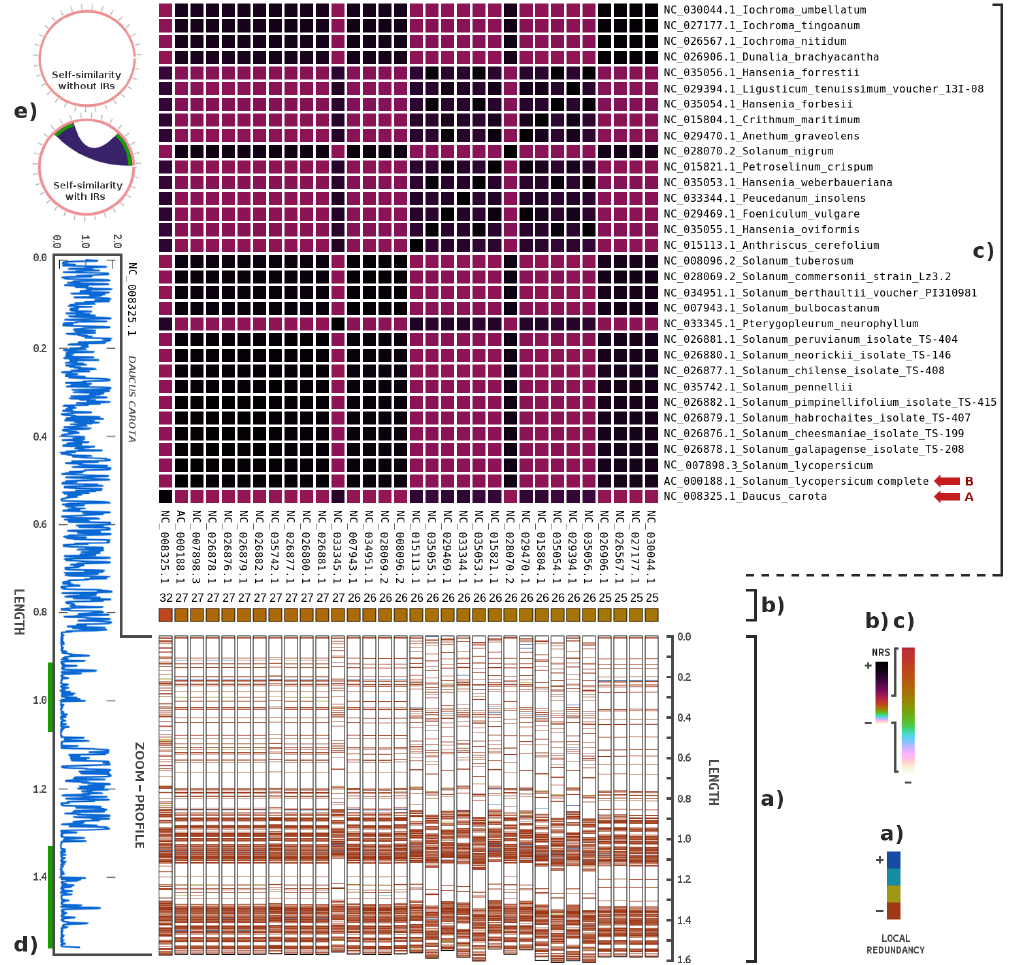
Figure 4. Metagenomic composition analysis of the PUM sample, particularly for plastid genomes: ( b ) The percentage of the highest NRS entries in descending order (from left to right), according to the order of the names on the right (from bottom to top). ( a ) Locations where the plastid genomes are similar relative to the reads, as well as their respective redundancies, mapped with four colours. ( c ) The intra-similarities of the plastid genomes based on the NRS. The matrix appears to be symmetric because the sizes of the samples are approximately the same. Length is presented in 10 5 . The sequence identifiers represent the names of the plastids. ( e ) The circular maps indicate where similarities are located among parts of the Daucus carota sequence. ( d ) The complexity profile of the sequence relative to that of the PUM sample [59]. Letters (in red) identify potential genomes contained in the